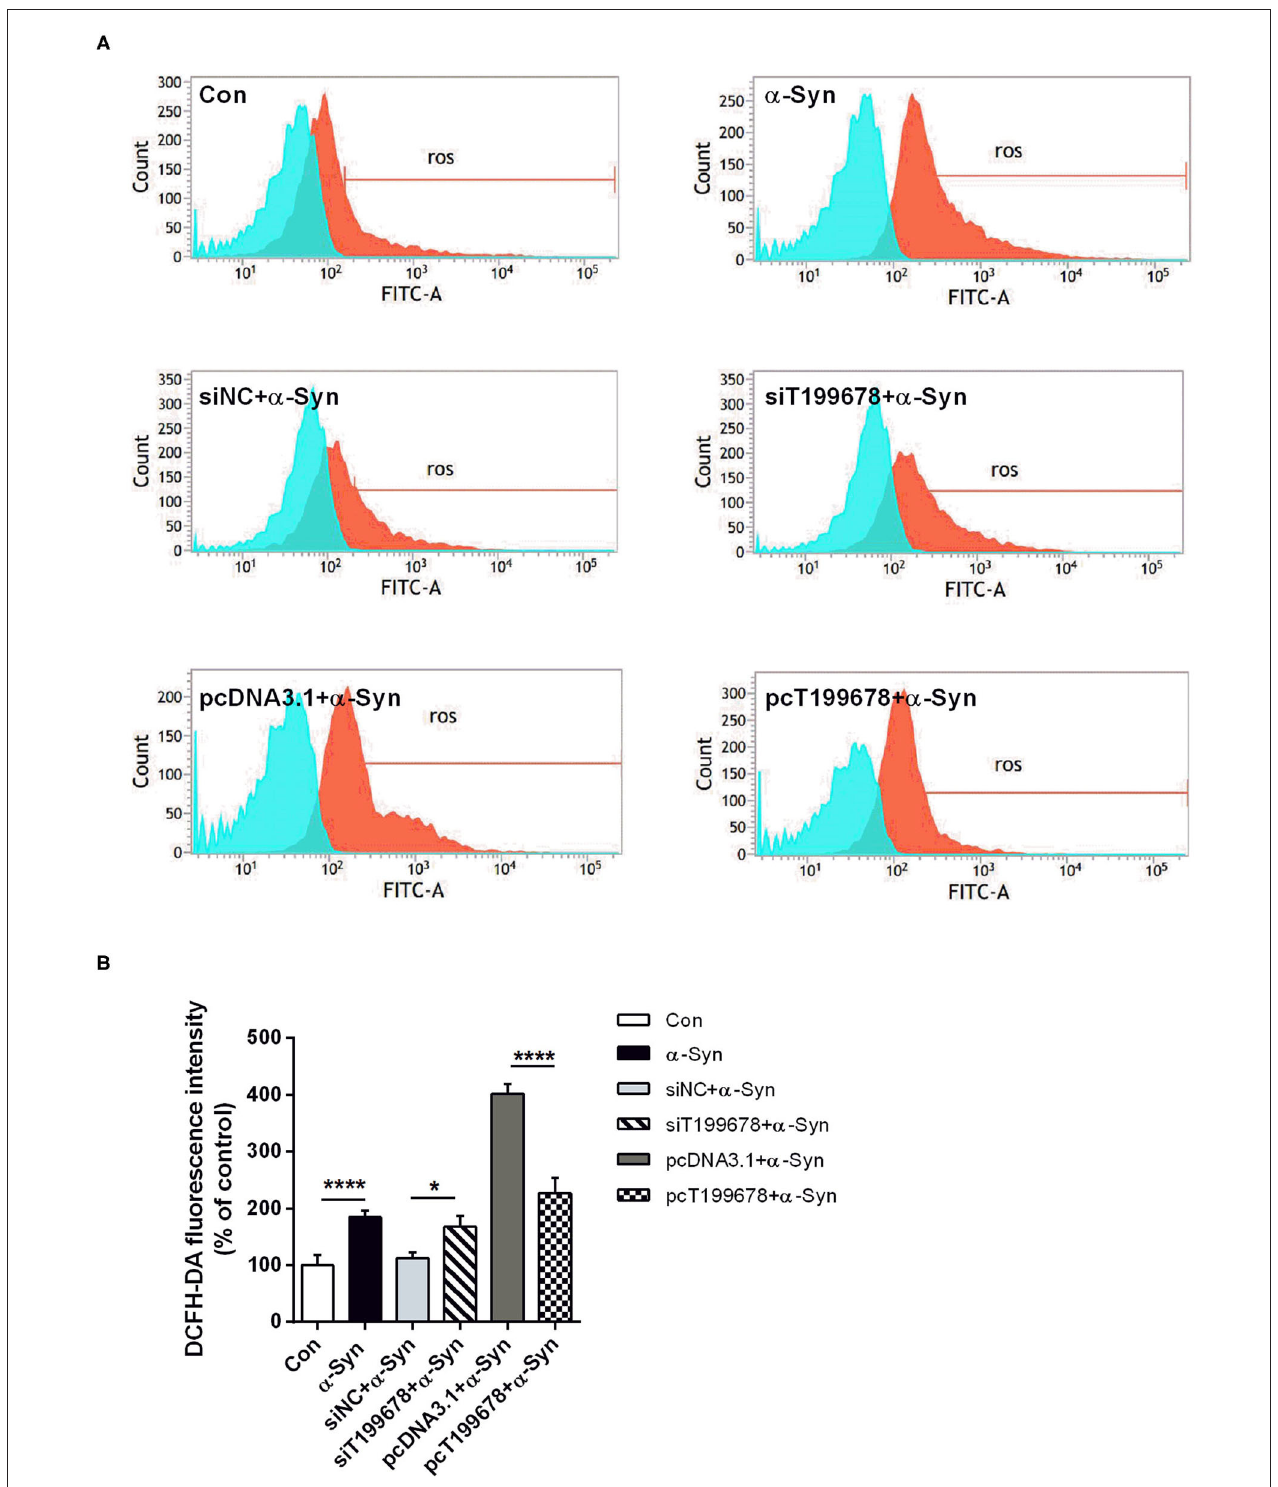
FIGURE 2 | Interference of lncRNA-T199678 ameliorated intracellular oxidative stress induced by α -Syn. SH-SY5Y cells were divided into six groups: control (wild type), α -Syn, siNC + α -Syn, siT199678 + α -Syn, pcDNA3.1 + α -Syn, and pc T199678 + α -Syn. (A) Oxidative stress injury (ROS) was detected via DCFH-DA probe and flow cytometry. (B) Fluorescence of DCFH-DA was detected by flow cytometry (one-way ANOVA, F = 143.1, df = 23, P < 0.0001, followed by Tukey’s multiple-comparison tests: Control vs. α -Syn, **** P < 0.0001; siNC + α -Syn vs. siT199678 + α -Syn, * P < 0.05; pcDNA3.1 + α -Syn vs. pc T199678 + α -Syn, **** P <